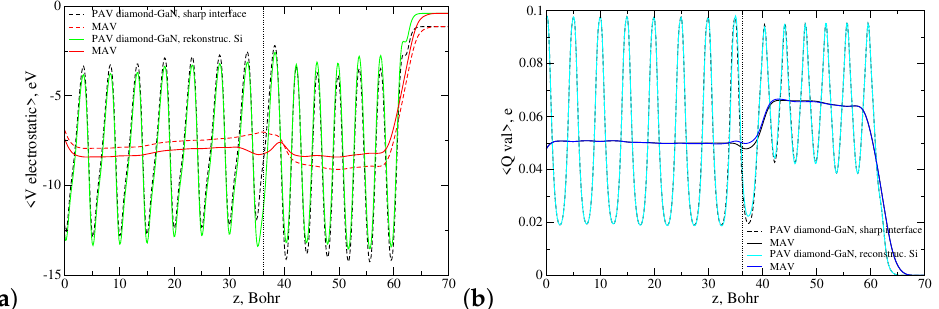
Figure 16. Course of laterally (PAV) and macroscopically (MAV) averaged profiles of the ( a ) electro- static potential and ( b ) valence electron charge density in the diamond–GaN heterostructure with the Ga-C abrupt and reconstructed interface types. The applied reconstruction pattern is 3 Ga + 1 Si Ga . A dotted line points to the average z-th position of the topmost Ga atoms.